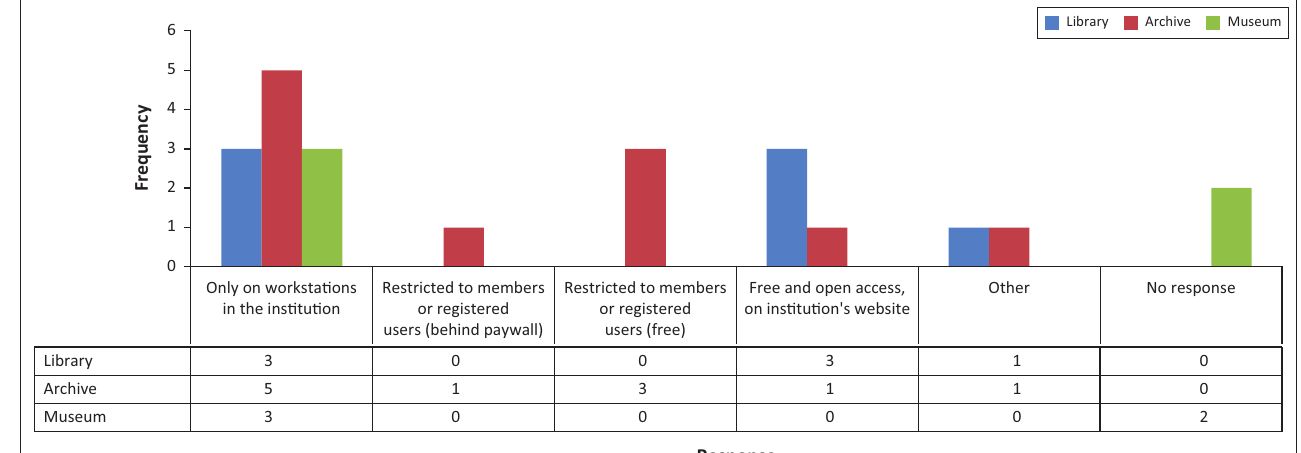
FIGURE 7: Manner of access ( N =